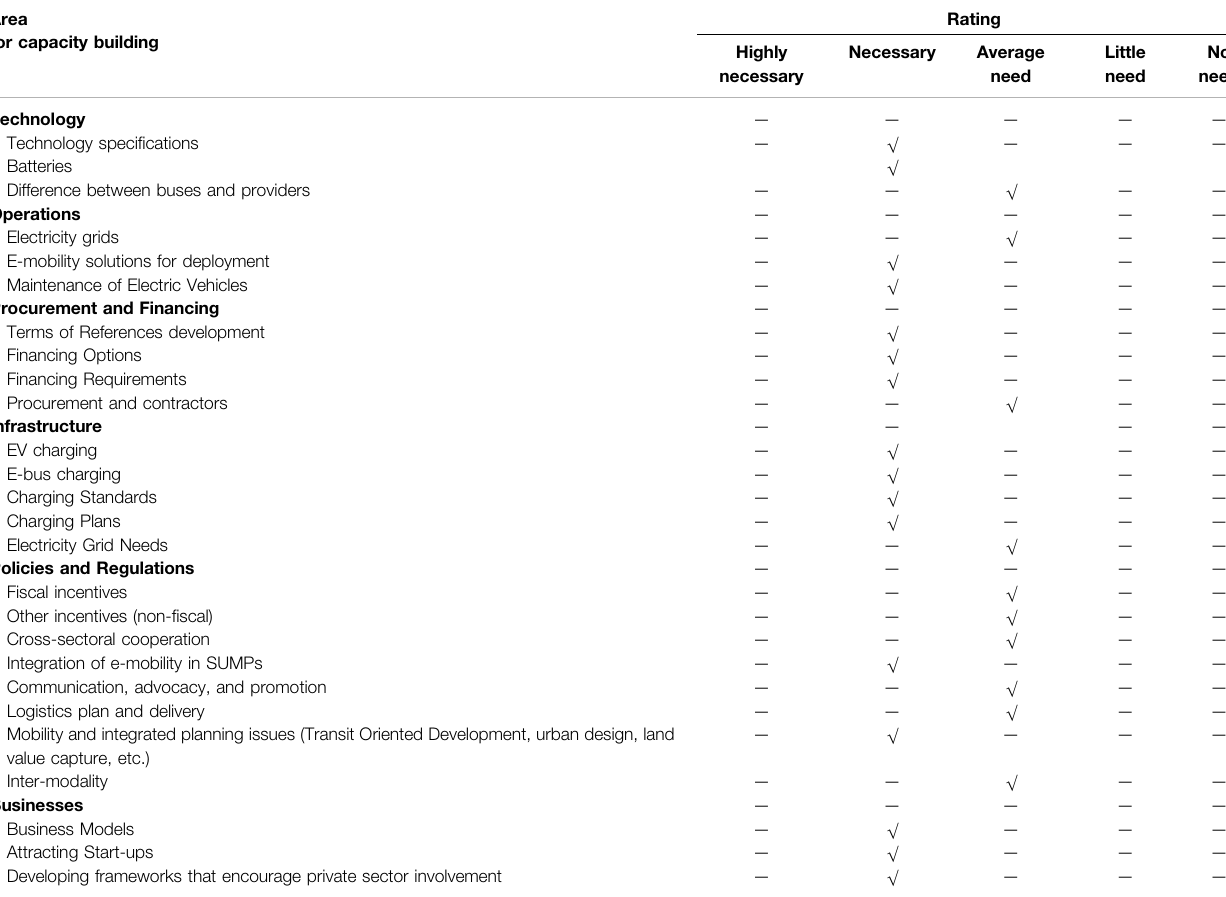
TABLE 2 | Categories of needs and corresponding